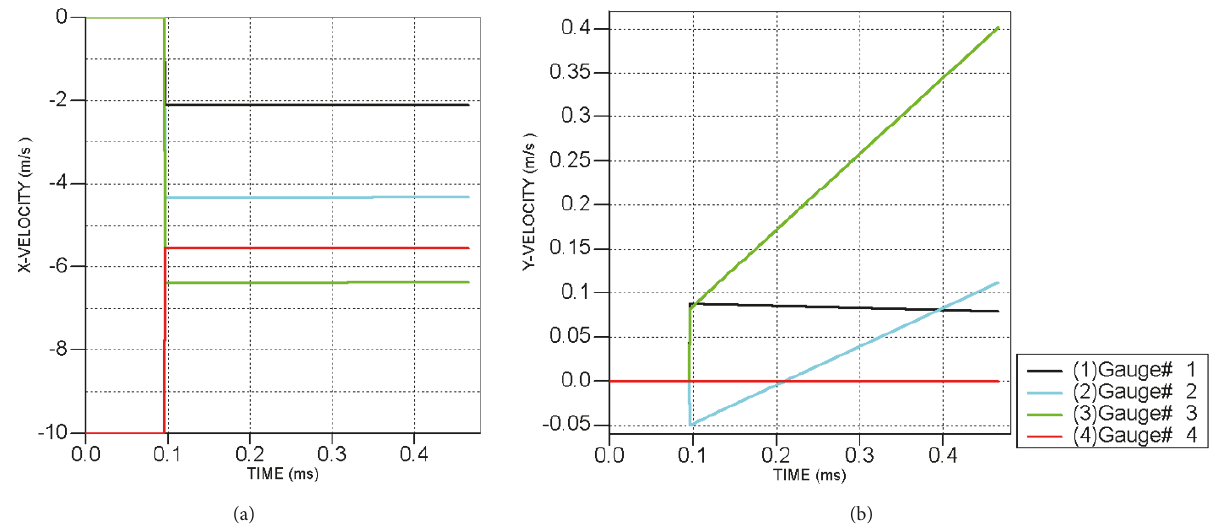
Figure 6: Velocity change during and after the plate-flywheel interaction: (a) linear velocity in horizontal direction and (b) linear velocity in vertical